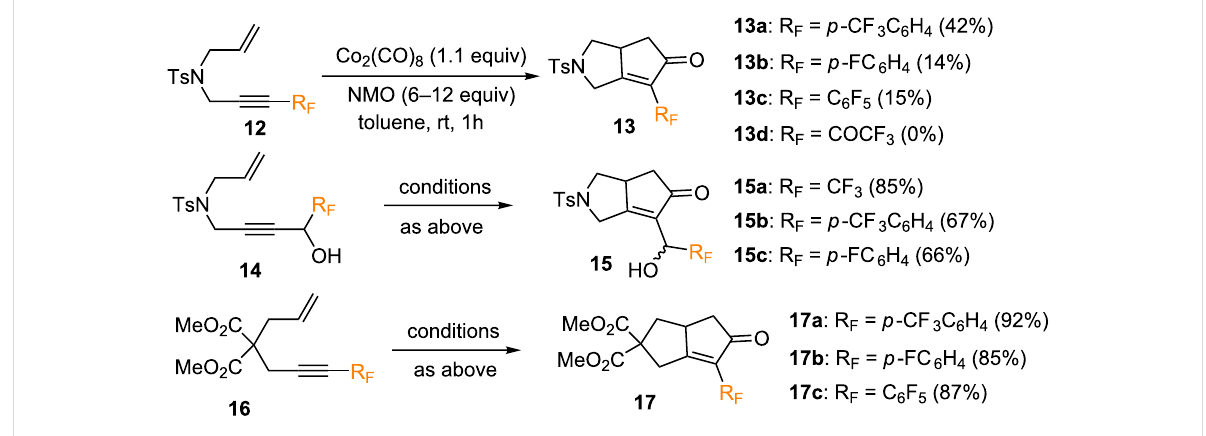
Scheme 7: PKR of enynes bearing fluorinated groups on the alkynyl moiety, reported by the group of Ishizaki [46]. Reaction conditions: i) Co(CO) 8 (1.1 equiv), toluene, rt, 1 h; ii) NMO (6–12 equiv), rt, 1 h.